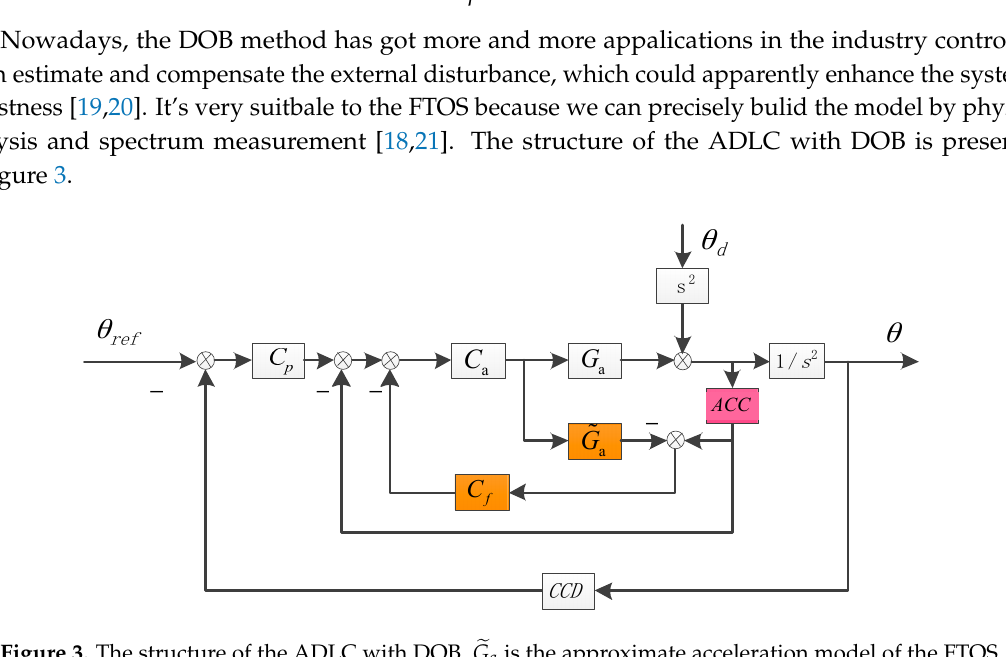
G  is the approximate acceleration model of the a